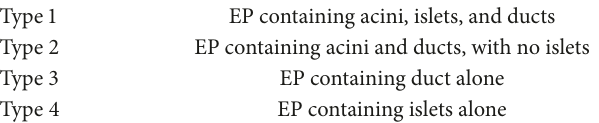
Table 1: Heinrich classification